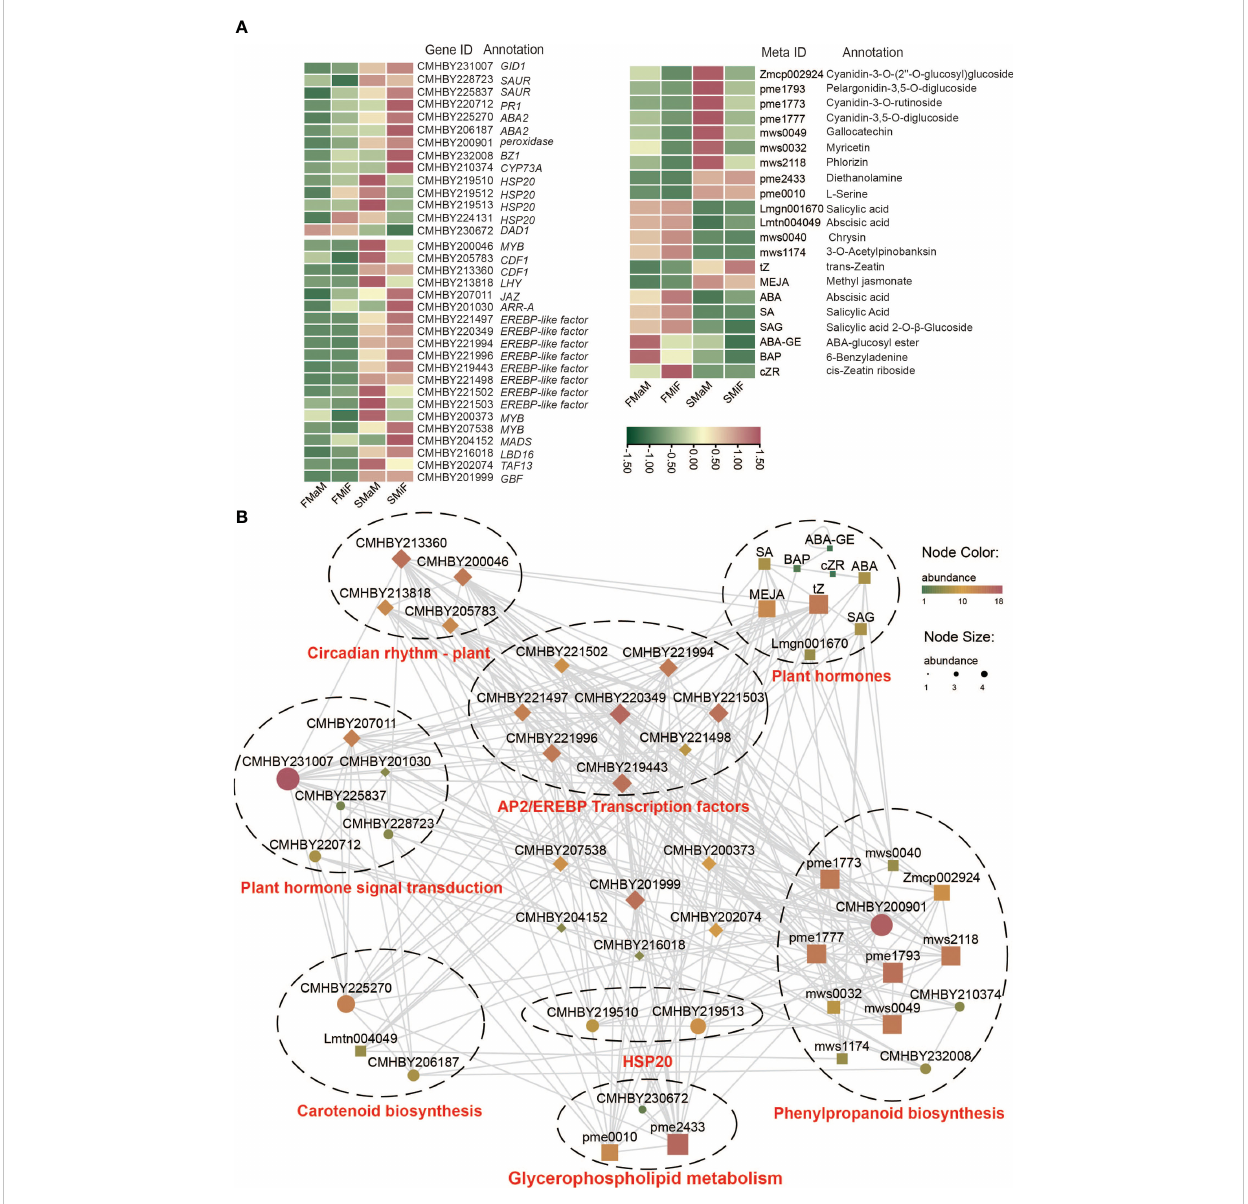
FIGURE 7 Correlation between DEGs, DAMs, and differential hormones of target pathways. (A) Heatmap of DEGs, transcription factors, DAMs and differential hormones. (B) Positive correlation between target genes and target metabolites. The node colour and size indicate the degree of connectivity, with larger nodes and redder colours indicating stronger connectivity between the